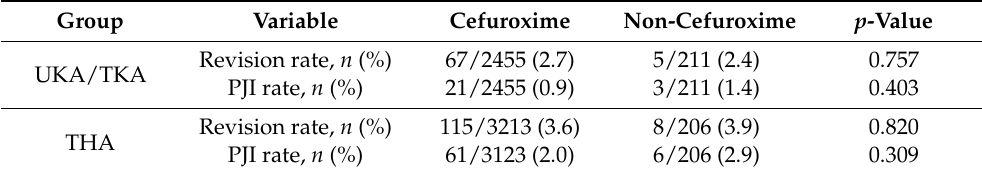
Table 3. Revision rate and PJI rate in knee arthroplasty group and total hip arthroplasty group according to prophylactic antibiotic.